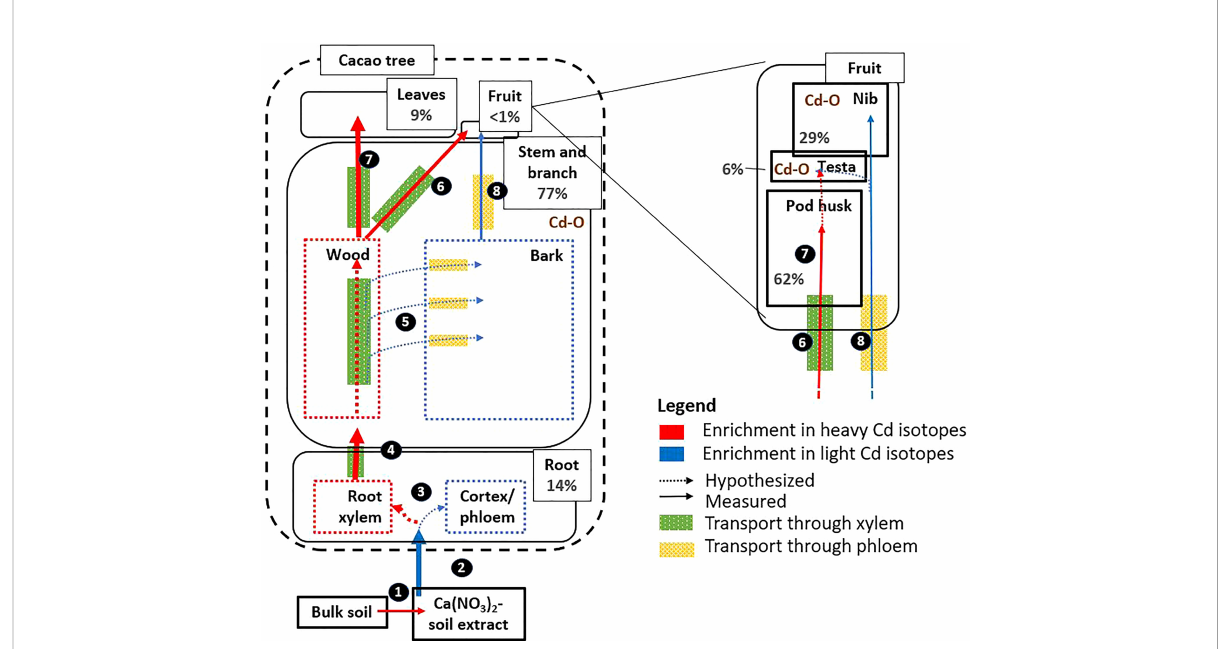
FIGURE 7 Proposition of Cd pathways, in high Cd accumulator NA 312 of cacao. The fi gure includes information on Cd mass balance (% in grey, size of the boxes and arrows are indicative to the main Cd fractions and transport rates), Cd isotope fractionation, and Cd speciation. 1) Desorbed Cd was isotopically heavier than adsorbed Cd. 2) The uptake of Cd 2+ inside the plant favors light isotopes, most likely through cross membrane transport with the protein TcNRAMP5 (Moore et al., 2020). 3) Cd was weakly retained in roots, and the majority was loaded in the xylem for further transport to the shoot, together with nutrients. 4) Preferentially heavy Cd isotopes were transported from root to shoot via the xylem. 5) In the branch, Cd was horizontally transferred from the xylem to the phloem in the branches. Lighter Cd isotopes accumulated mostly in the bark (phloem vessels and periderm), while heavier Cd isotopes remained in the xylem. In the branches, Cd was bound to carboxyl ligands, probably to organic acids and/or cell wall components (Cd-O). 6) Cd that accumulated in the branches (i.e. wood and bark), was transported directly to the fruits by both xylem and phloem. 7) Leaves and pod husks received heavier Cd isotopes from the progressive retention of light Cd isotopes in the branches. 8) The nibs were isotopically lighter than the pod husks due to transfer of lighter Cd from the phloem into the nibs. The testa received Cd from both xylem and phloem. The nib was a phloem sink where the majority of Cd was complexed to Cd-O, with phytate as the most plausible ligand. In the testa, Cd was complexed to Cd-O, and more likely to cell wall components or organic acids. Figure layout based on (Kiczka et al.,